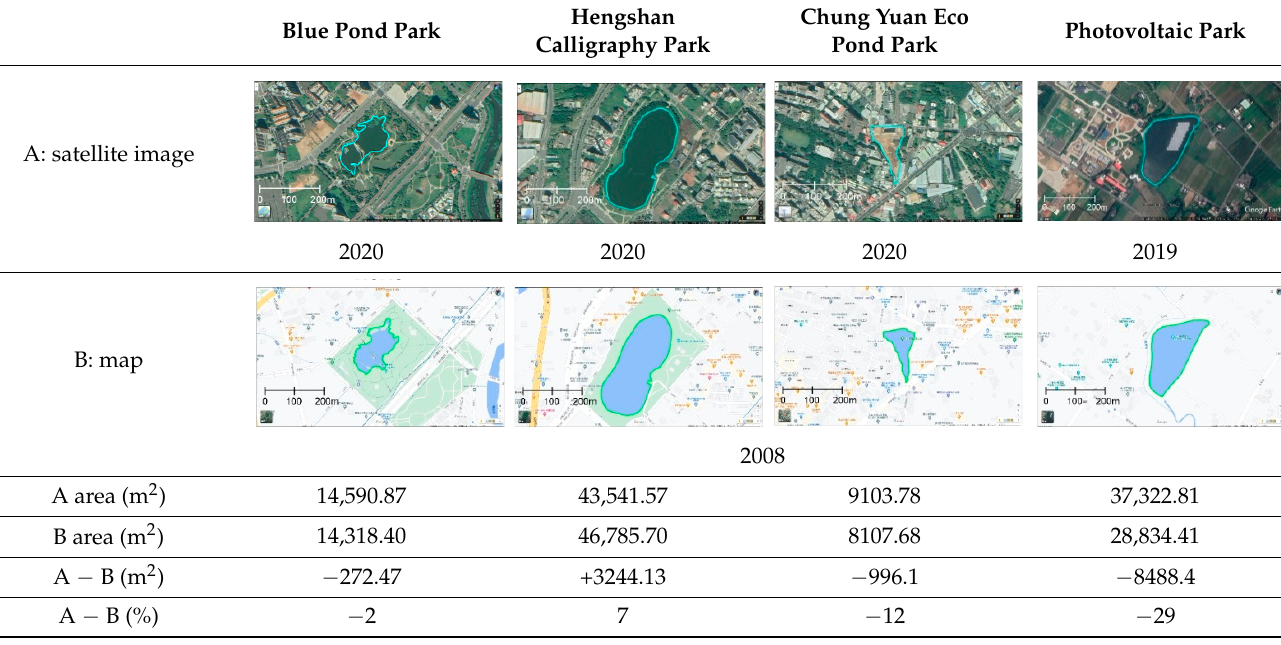
Table 4. The annual changes in pond water area (m 2 ) between satellite image and map.